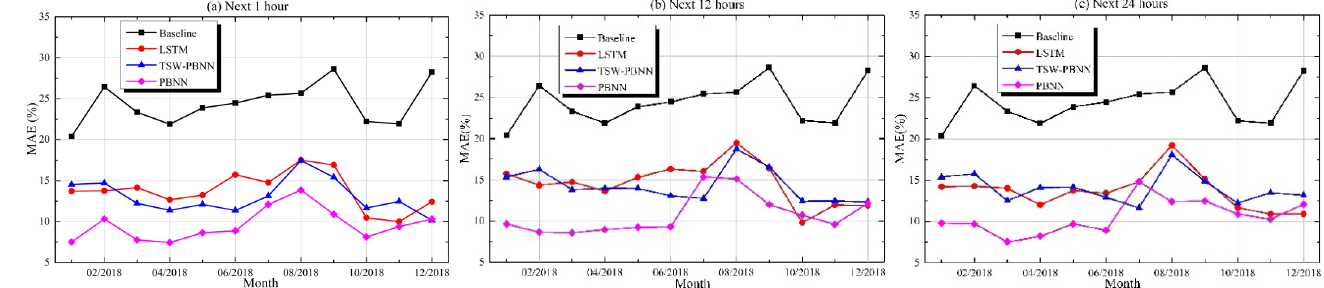
Figure 11. Error comparison of LSTM, TSW-PBNN, and PBNN predictions at different times.